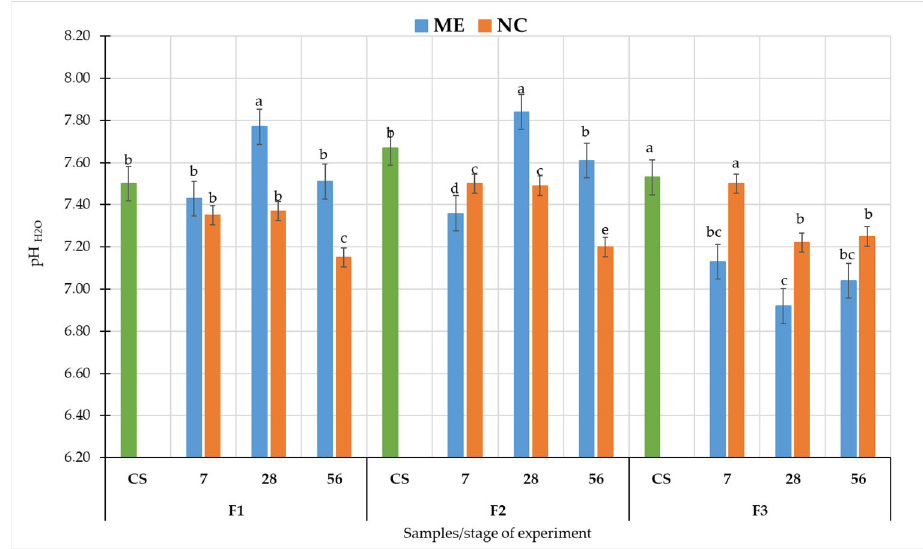
Figure 4. Soil pH H2O values in different experimental conditions. Different lower ‐ case letters “a–e” indicate significant differences for the same soil sample in different experimental variants (control, simulated flooding, natural flooding) at p < 0.05 (Tukey HSD test; n = 9). Explanation of the samples in Table 1.